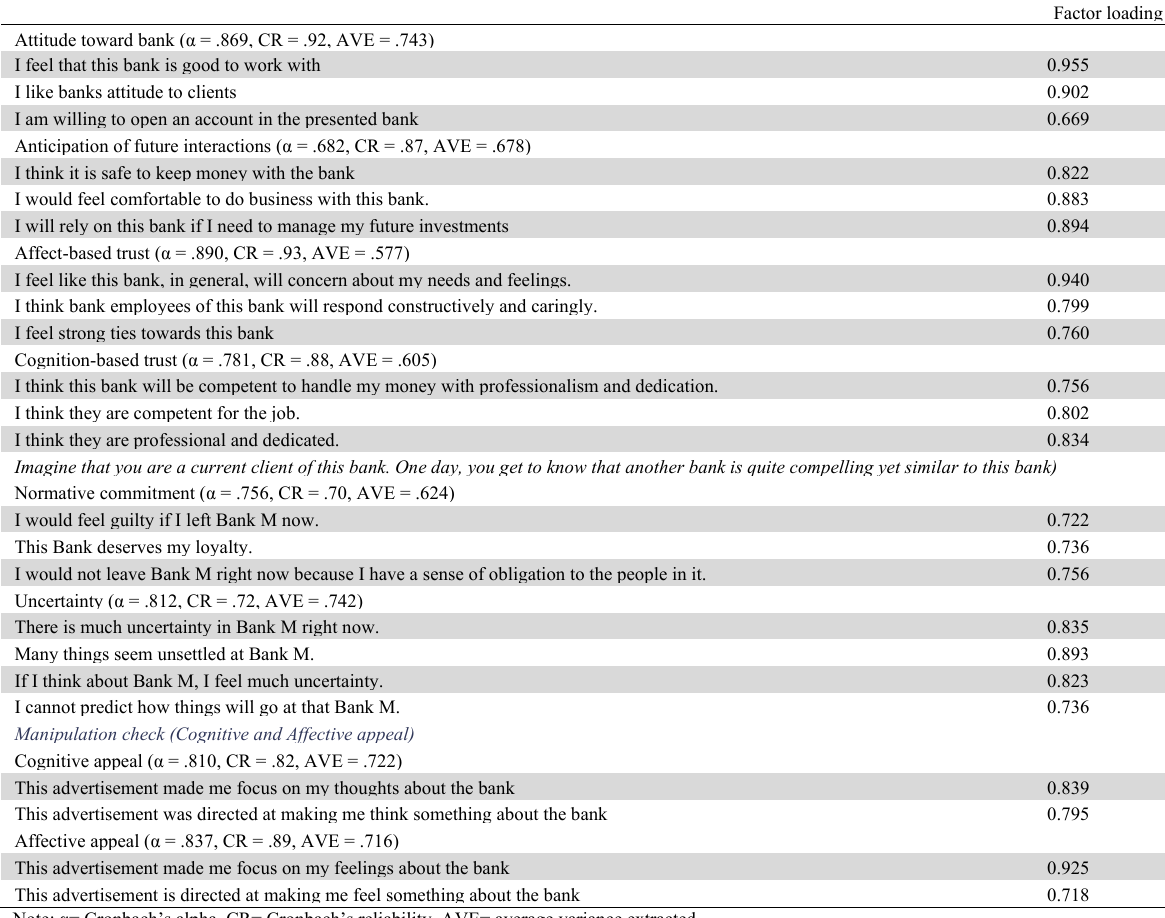
Measurement models